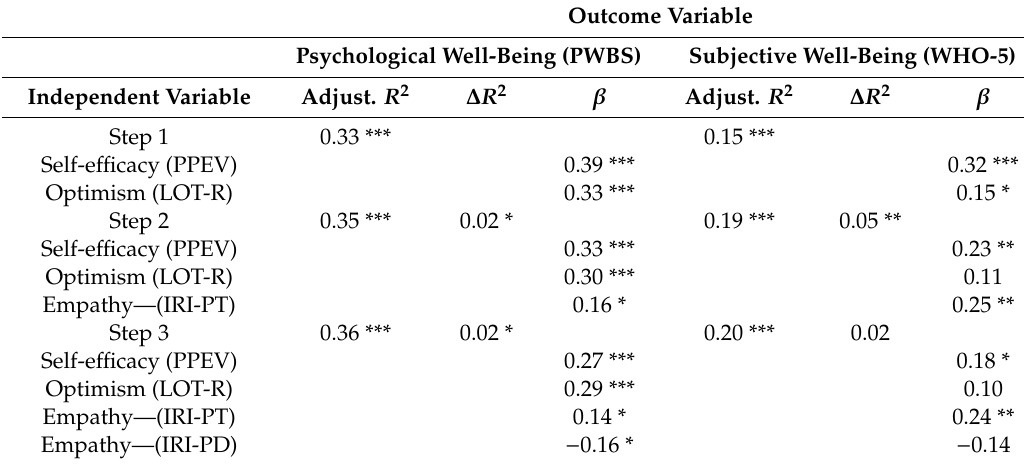
Table 3. Results of Hierarchical Linear Regression